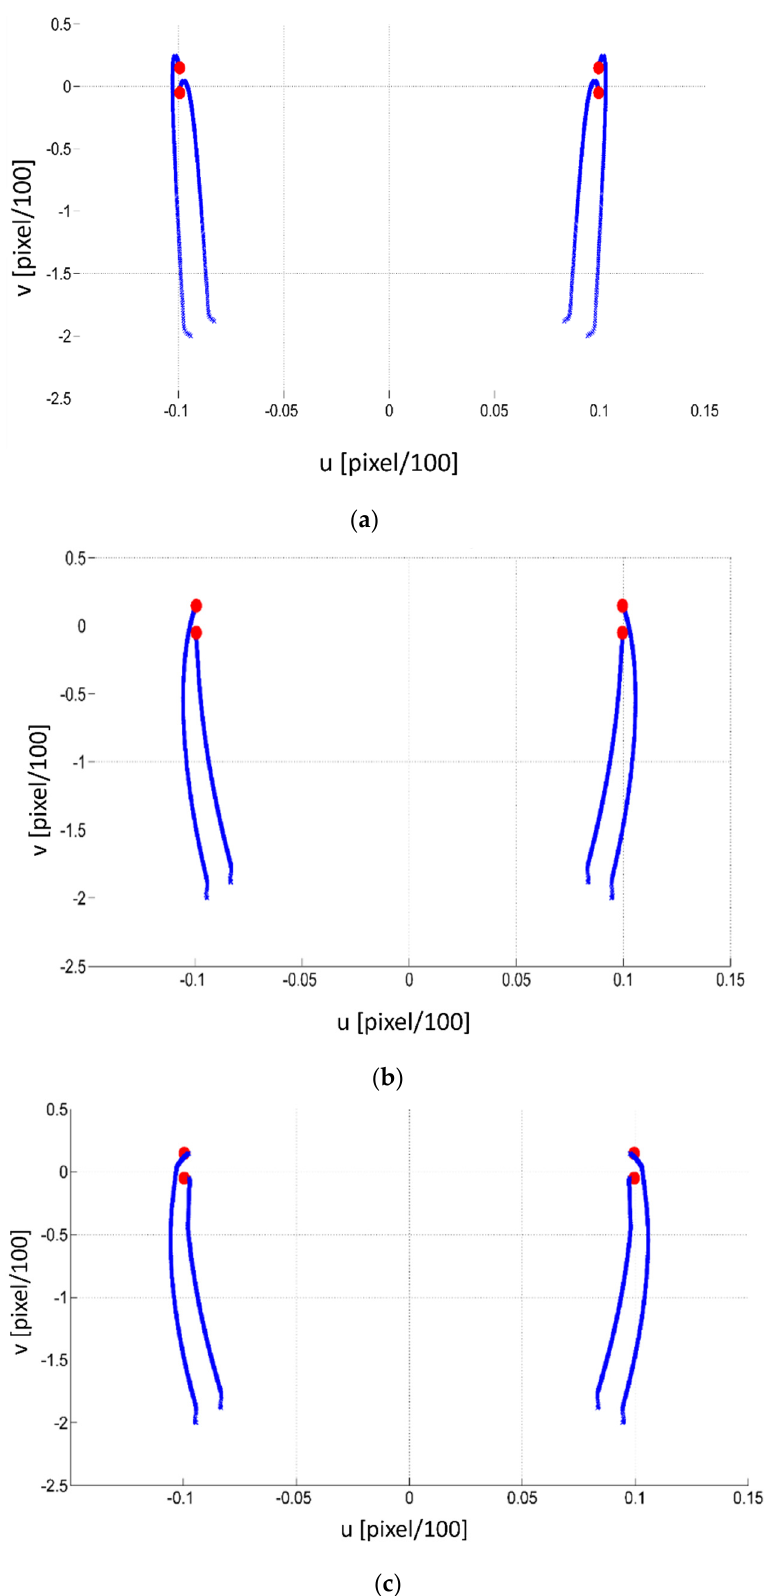
Figure 9. ( a ) Simulation of the extracted features evolution based on image frame based on IBVS, ( b ) PBVS, ( c ) HBVS.